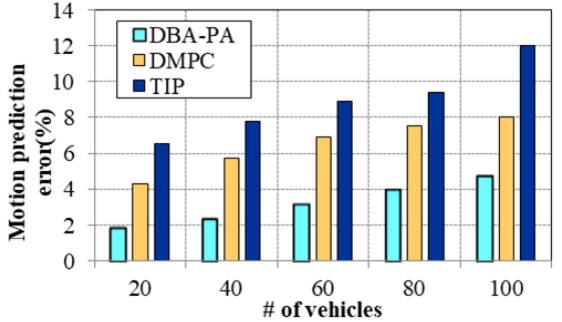
Figure 5. Number of Vehicles vs. Motion Prediction Error.